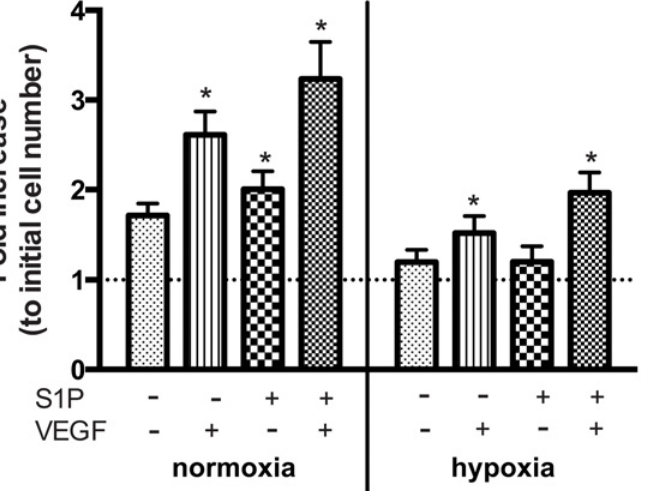
Fig 2. The combination of S1P and VEGF induced greater OEC proliferation than either individual stimulus under both normoxia and hypoxia. Data are mean ± SD (n = 6) and normalized to the initial cell seeding number (indicated by dashed line). An asterisk indicates statistically significant differences (P < 0.05) between conditions in normoxia or hypoxia respectively.